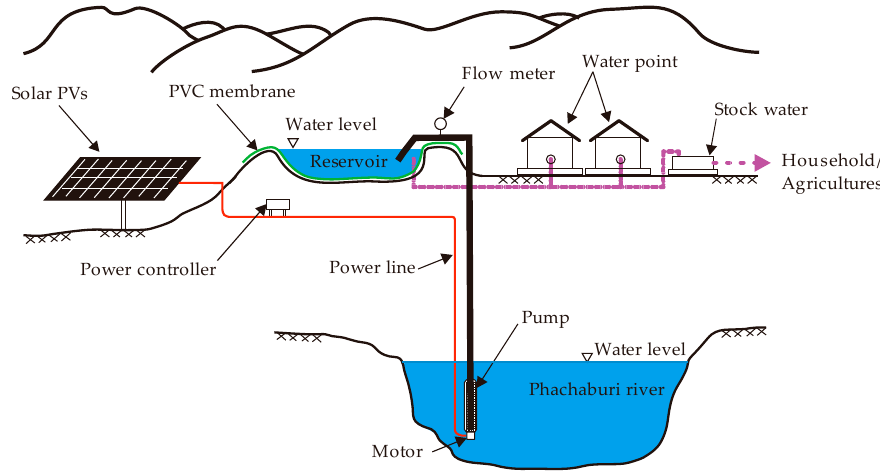
Figure 5. Schematic design of a Solar Water Supply System (SWSS) for the agricultural areas in this project.